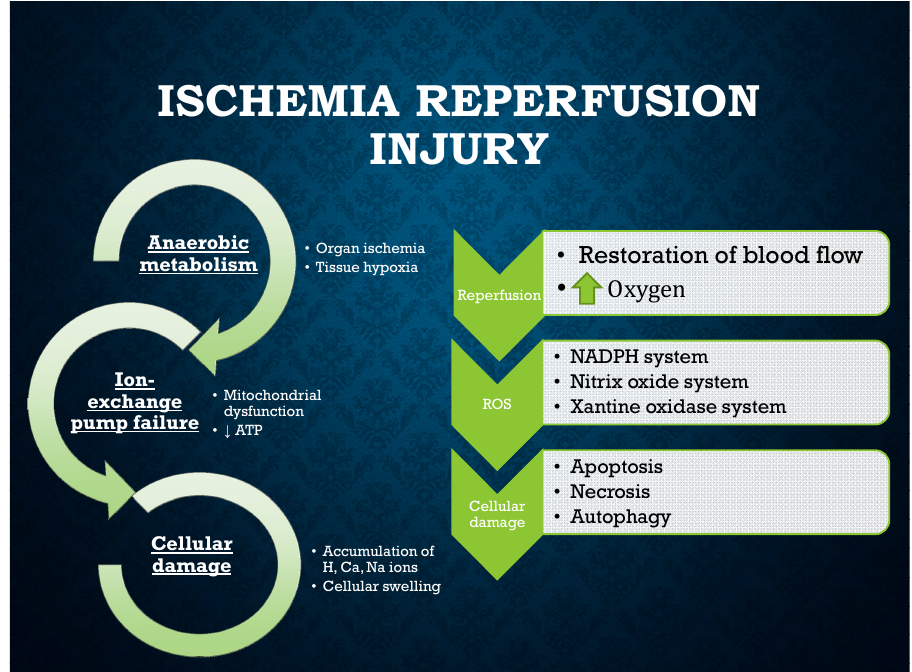
Figure 1. Mechanism responsible for IRI